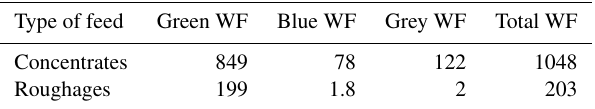
Table 3. Average water footprint (WF; green, blue, grey and total; m 3 t − 1 ) for concentrates and roughages (Mekonnen and Hoekstra,